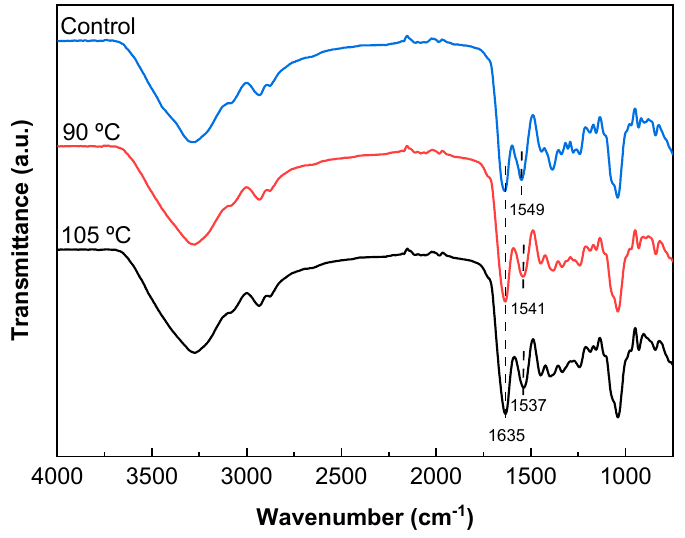
Figure 2. FTIR spectra of control and thermally treated films.